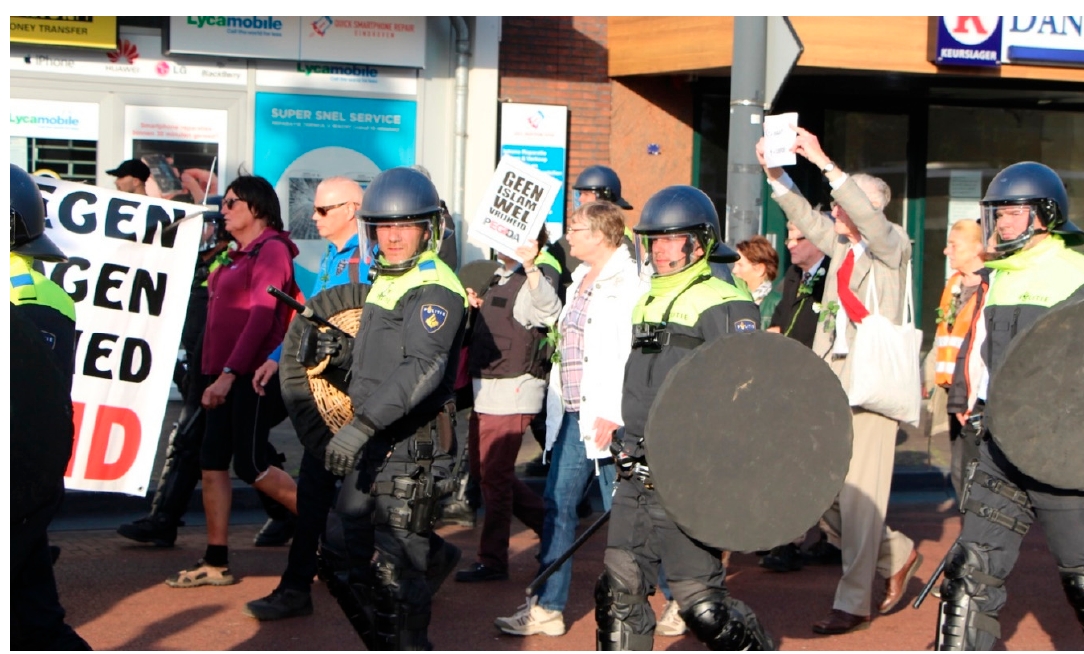
Figure 3. Pegida protesters walking down the Woenselse Markt in Eindhoven. Photo taken by the author.